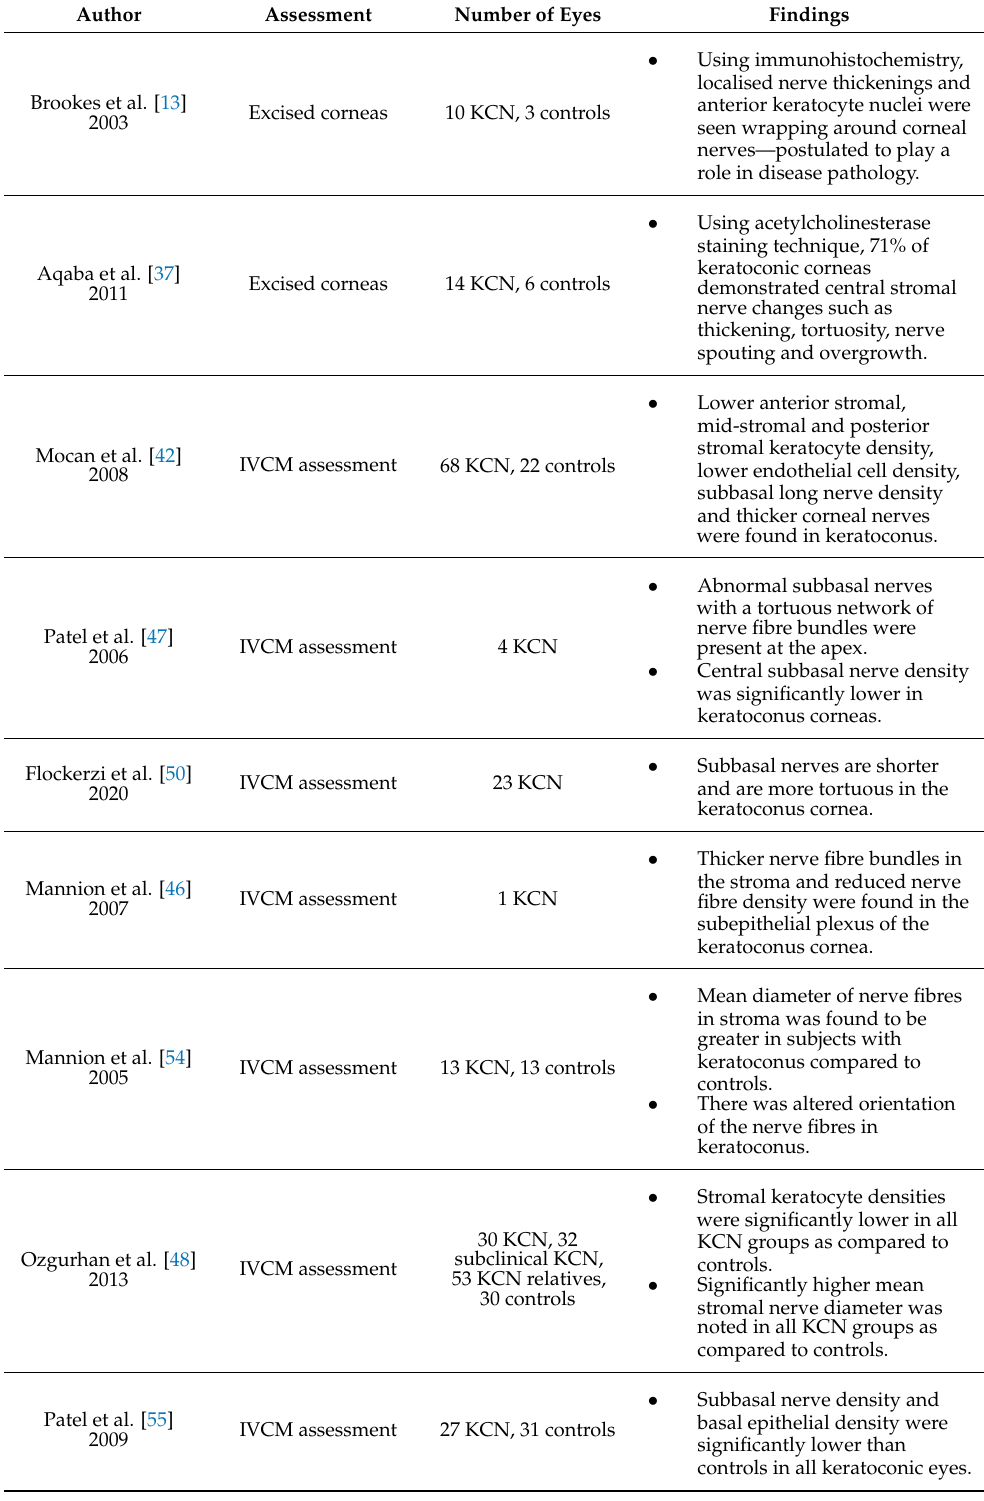
Table 1. Results of main studies investigating cellular and corneal nerve changes in